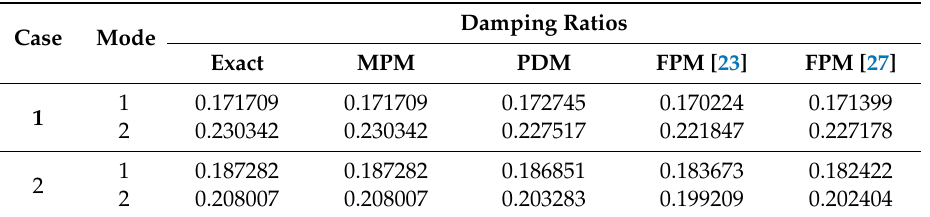
Table 2. The damping ratios of the 2 DOFs system.